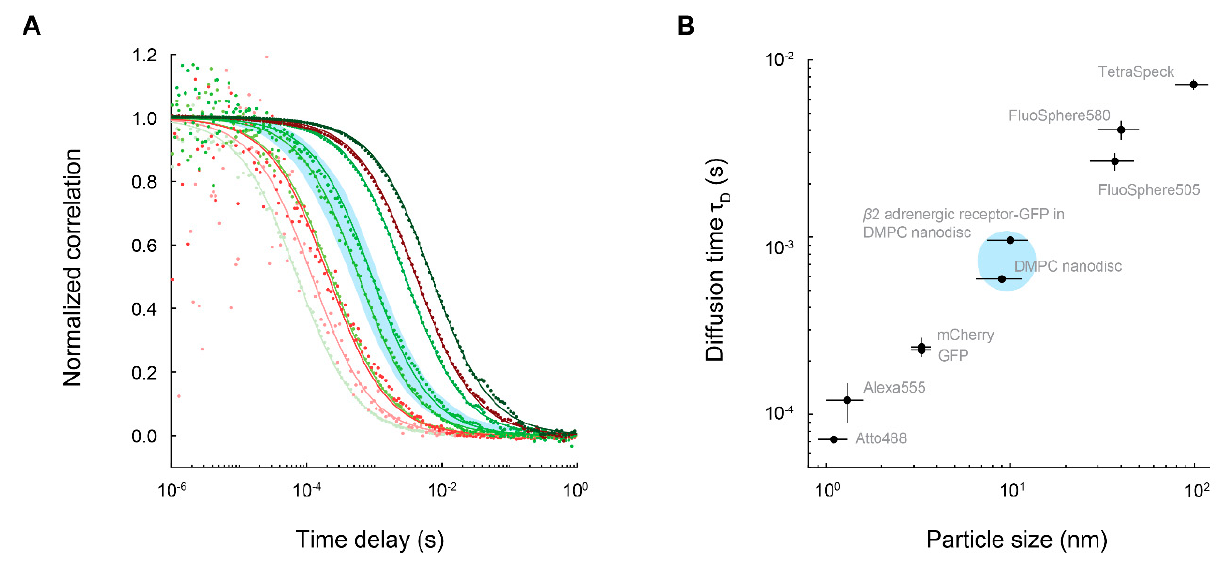
Figure 4. FCS correlation curves and diffusion times of nanodisc-embedded membrane proteins among a large range of particle sizes. ( A ) A representative correlation curve, from data collected for 1 min, for each species given in ( B ). Blue shaded area represents the range in which curves for membrane proteins embedded in nanodiscs are expected to reside. Green shades represent data collected with 488 nm laser excitation, and red shades represent data collected with 561 nm laser excitation. Data were collected on a homemade FCS system with a calibrated detection volume of ~3 µm 3 . ( B ) Diffusion times of different species plotted against particle size (diameter). Error bars on diffusion times are standard deviations based on multiple measurements. Error bars on size are estimated from diameters of the species. Blue shaded area represents the range in which nanodisc-embedded membrane proteins are expected to reside. Atto488 (Sigma-Aldrich, St. Louis, MS, USA, product #41051); Alexa555: Alexa Fluor 555 NHS ester (Thermo Fisher Scientific, Carlsbad, CA, USA, product #A20009); FluoSphere505 and FluoSphere580: FluoSpheres fluorescent carboxylate-modified microspheres 0.04 µm (Thermo Fisher Scientific, product #F10720); TetraSpeck: TetraSpeck fluorescent microspheres 0.1 µm (Thermo Fisher Scientific, product #T7279).